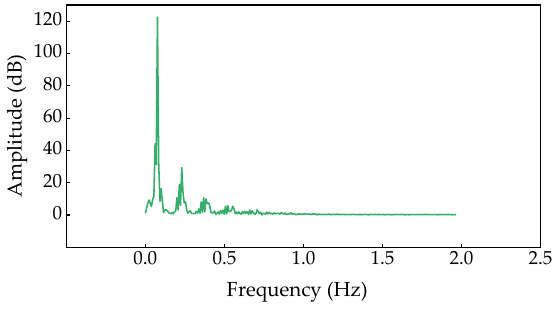
Figure 8. Spectrum of SFSCC20.